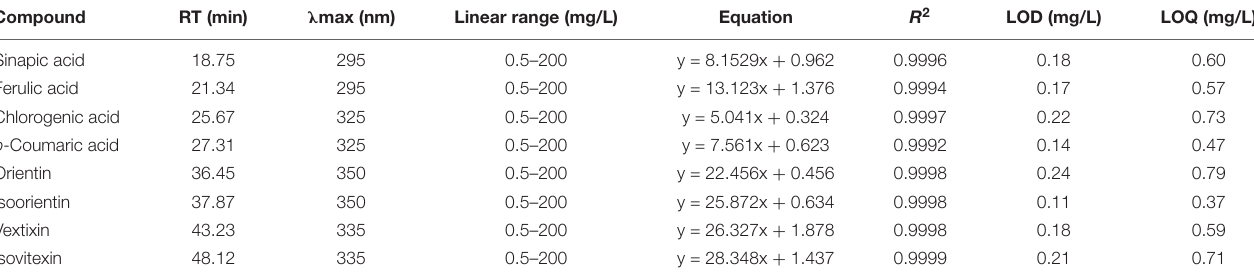
TABLE 1 | Quantification parameters of the HPLC method used.